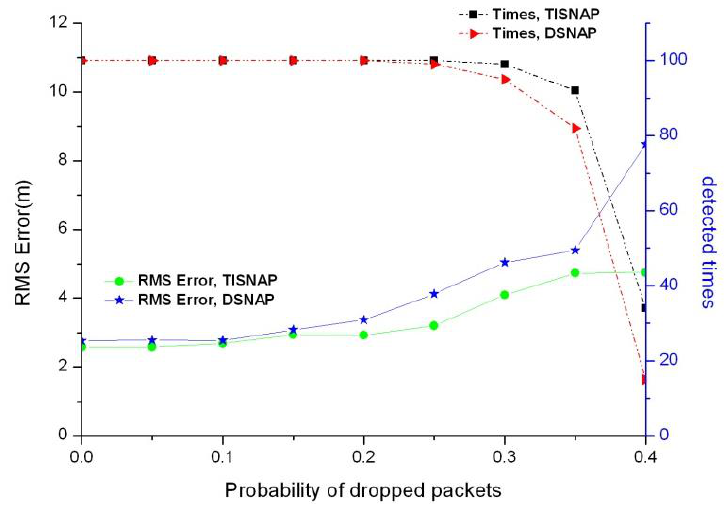
Figure 7. The Fault tolerance performance under different probability of dropped